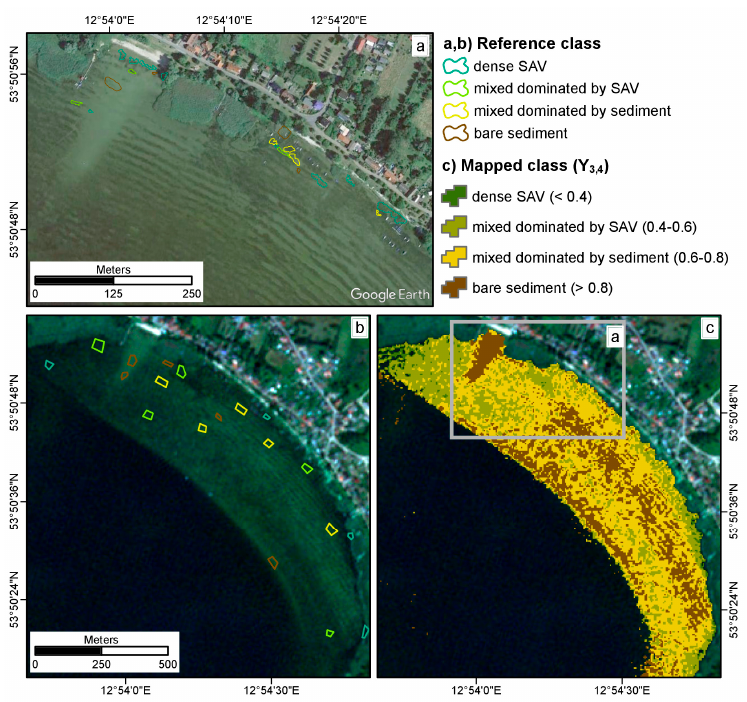
Figure 5. Evaluation of SAV mapping with ( a ) In situ observed littoral bottom coverage highlighted in Google Earth imagery (acquisition date: 9 August, Image © 2017 TerraMetrics); ( b ) Reference areas based on Google Earth imagery and transferred to RapidEye (acquisition date: 1 August); ( c ) Categorised depth-invariant index Y 3,4 of RapidEye data. Contains material © (2015) Planet Labs. All rights